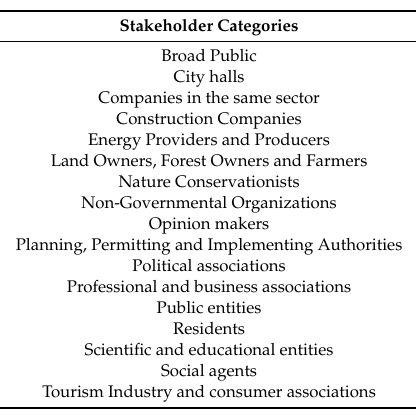
Table A1. Stakeholder